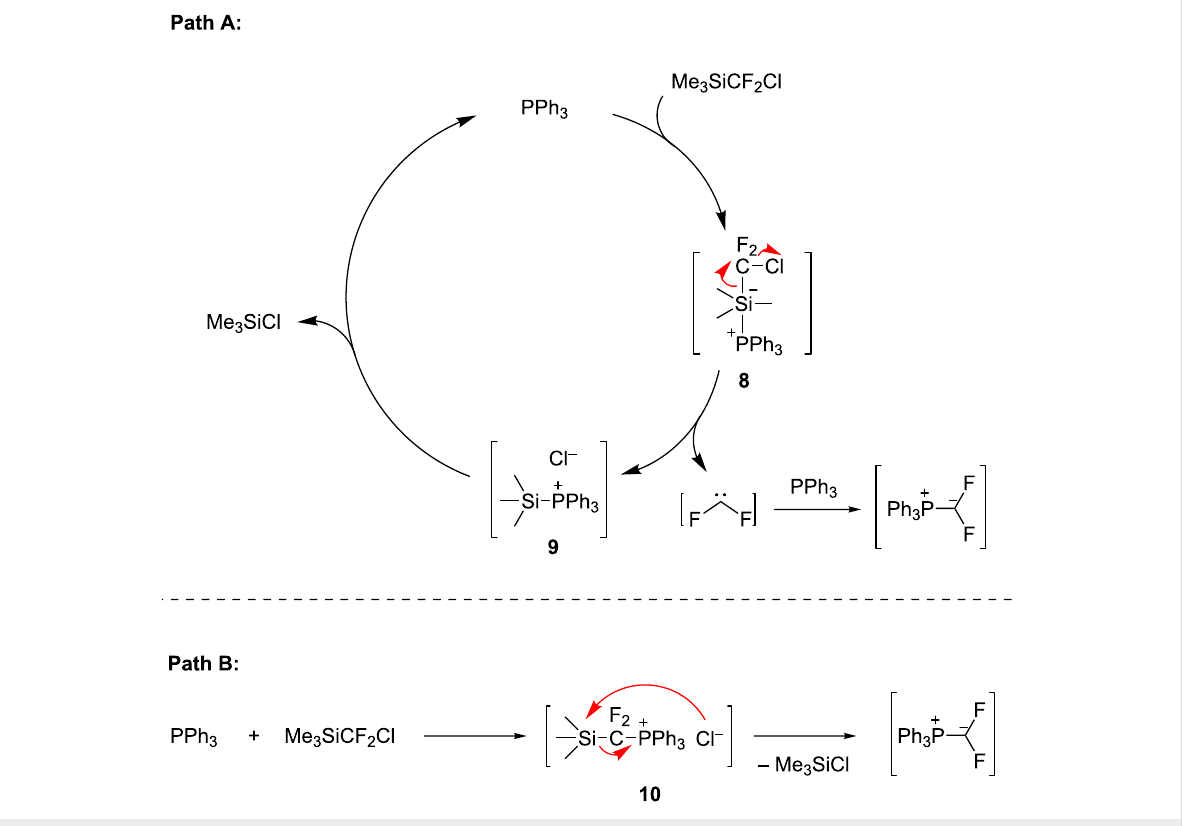
Scheme 5: Plausible mechanisms for the formation of difluoromethylene triphenylphosphonium ylide from TMSCF 2 Cl and PPh 3